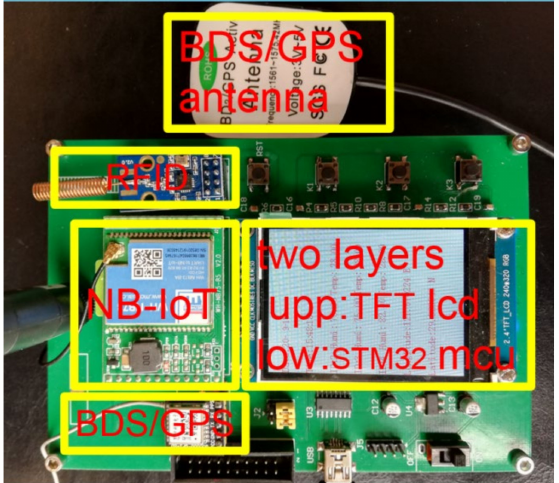
Figure 2. The Sink node physical